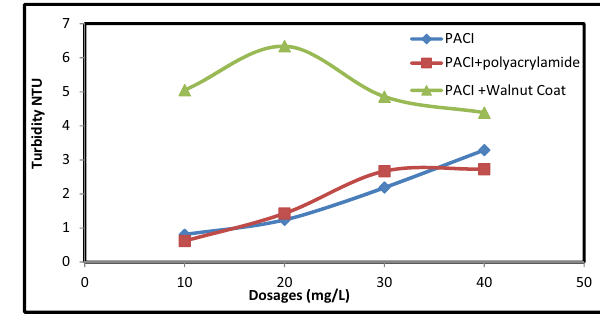
Figure 19: The relation between coagulant aids and fi nal turbidity for water samples at 120 cm height.